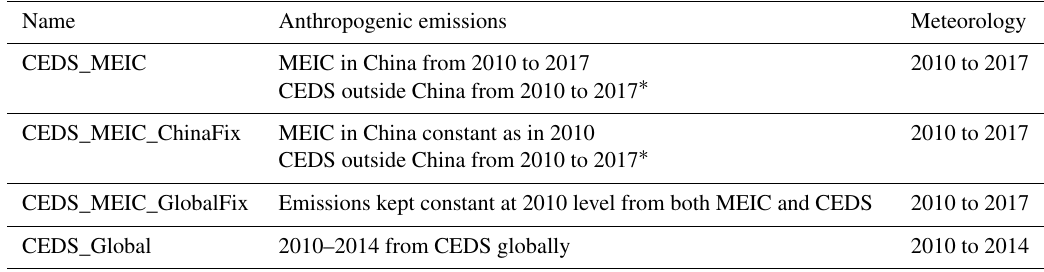
Table 1. Model simulation performed for this